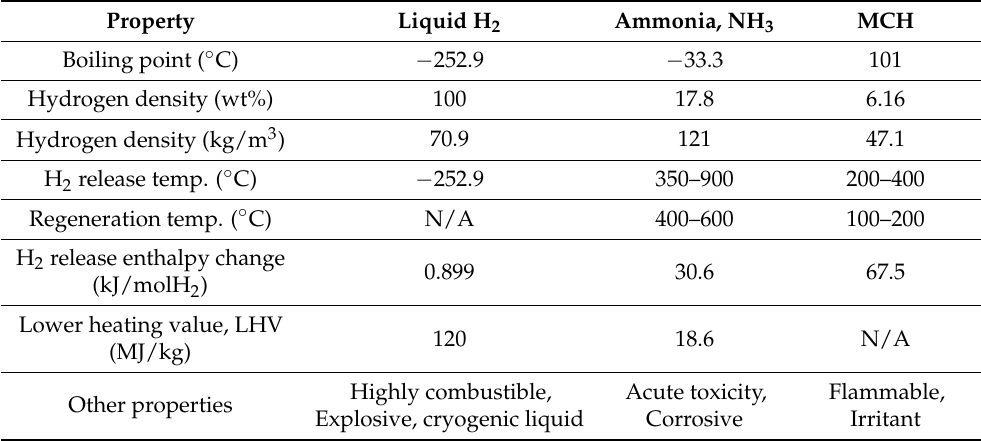
Table 2. Properties and characteristics of the prominent potential hydrogen carriers [23–26].